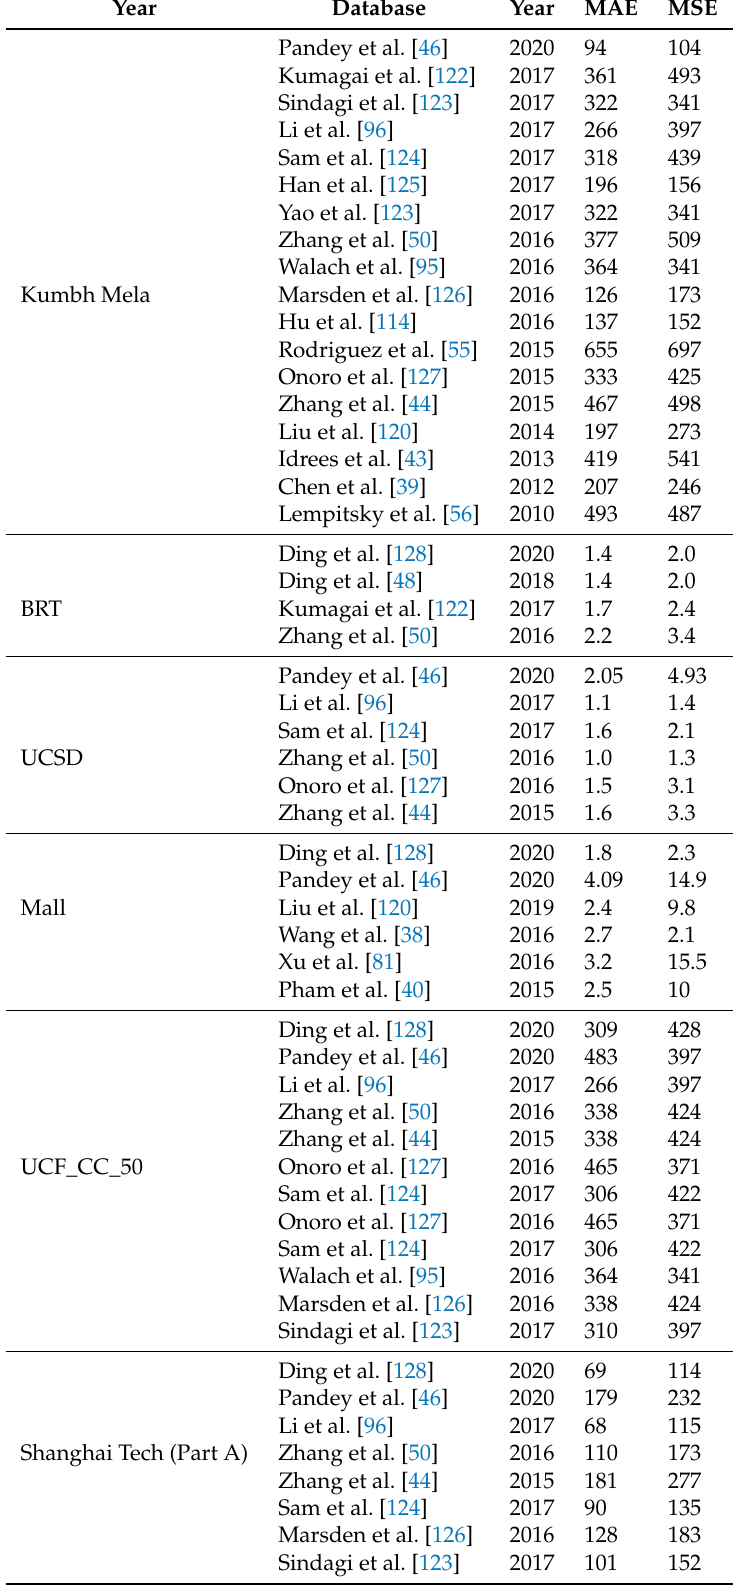
Table 3. CMS performance in the form of mean absolute error (MAE) and mean squared error